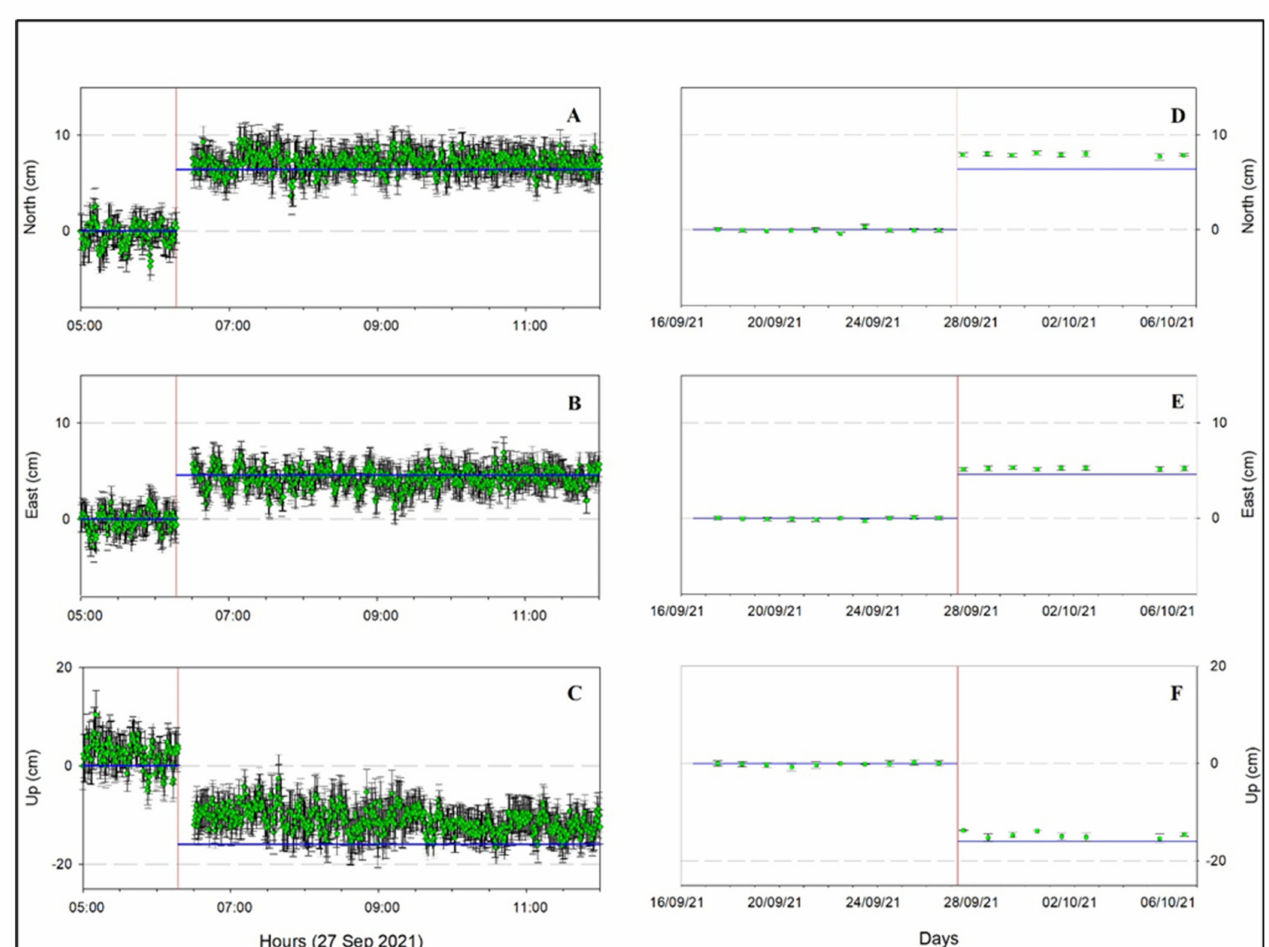
Figure 6. Position time series showing co-seismic and early post-seismic displacements in the north ( A ), east ( B ) and vertical ( C ) components of ARKL GNSS station. Panels ( A – C ) show the results of early post-seismic deformation (hours) relative to MOI1 station using the TRACK module. Panels ( D – F ) show early post-seismic deformation (days) using the daily solution time-series of GAMIT/GLOBK moduli. Red line indicates the time of the earthquake and blue lines indicate our best-fit model